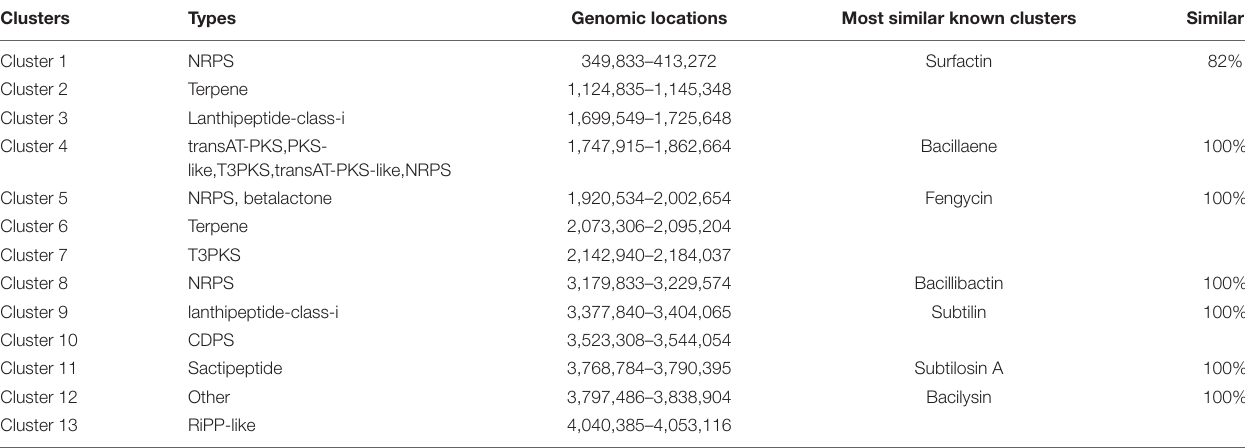
TABLE 4 | List of the putative gene clusters encoding for secondary metabolites by antiSMASH in the B. subtilis YB-04 genome. Clusters